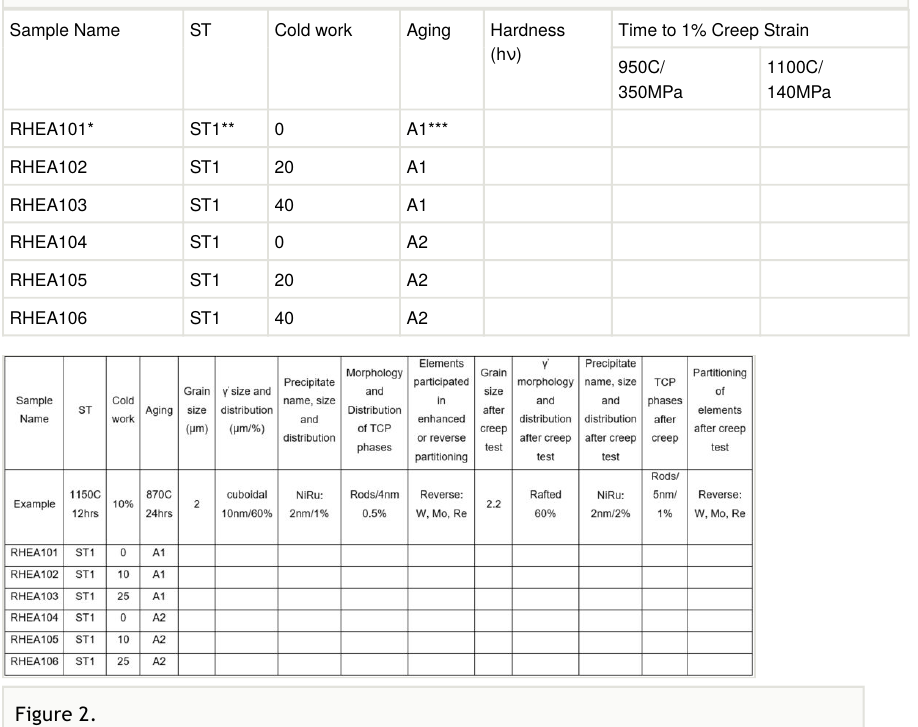
All features of the microstructures from the six samples taken before and after creep